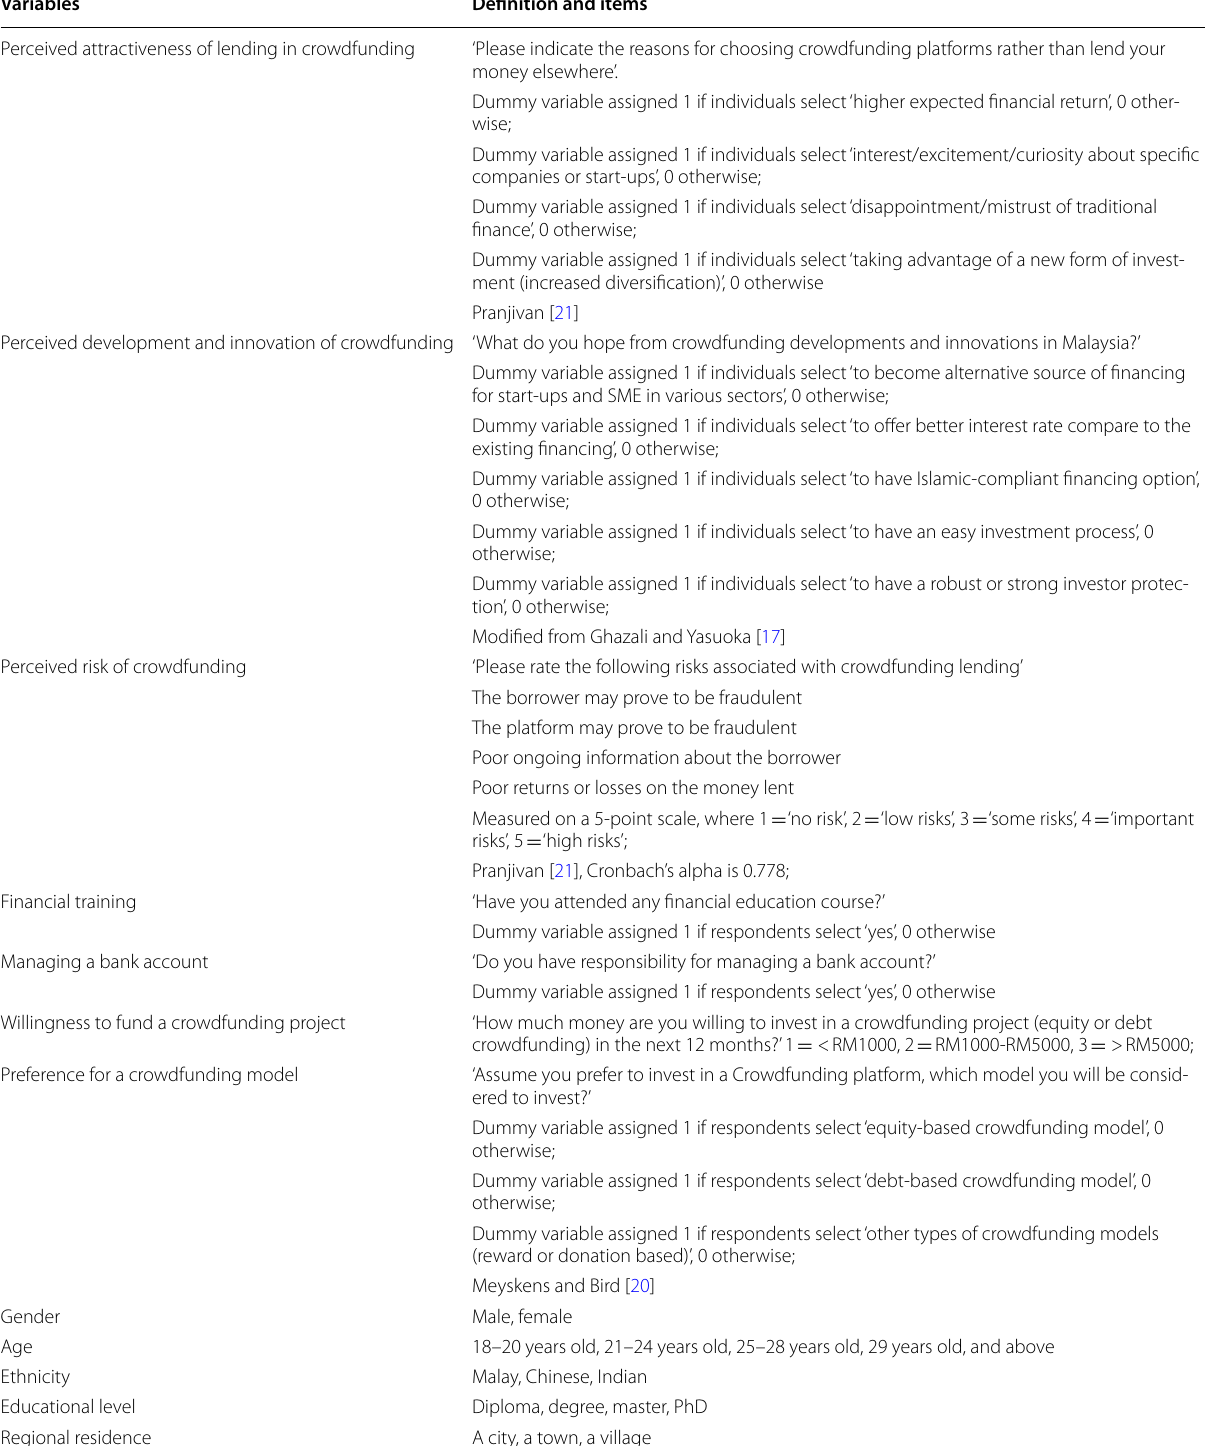
Table 1 Measurement of independent variables and dependent variable Variables Definition and